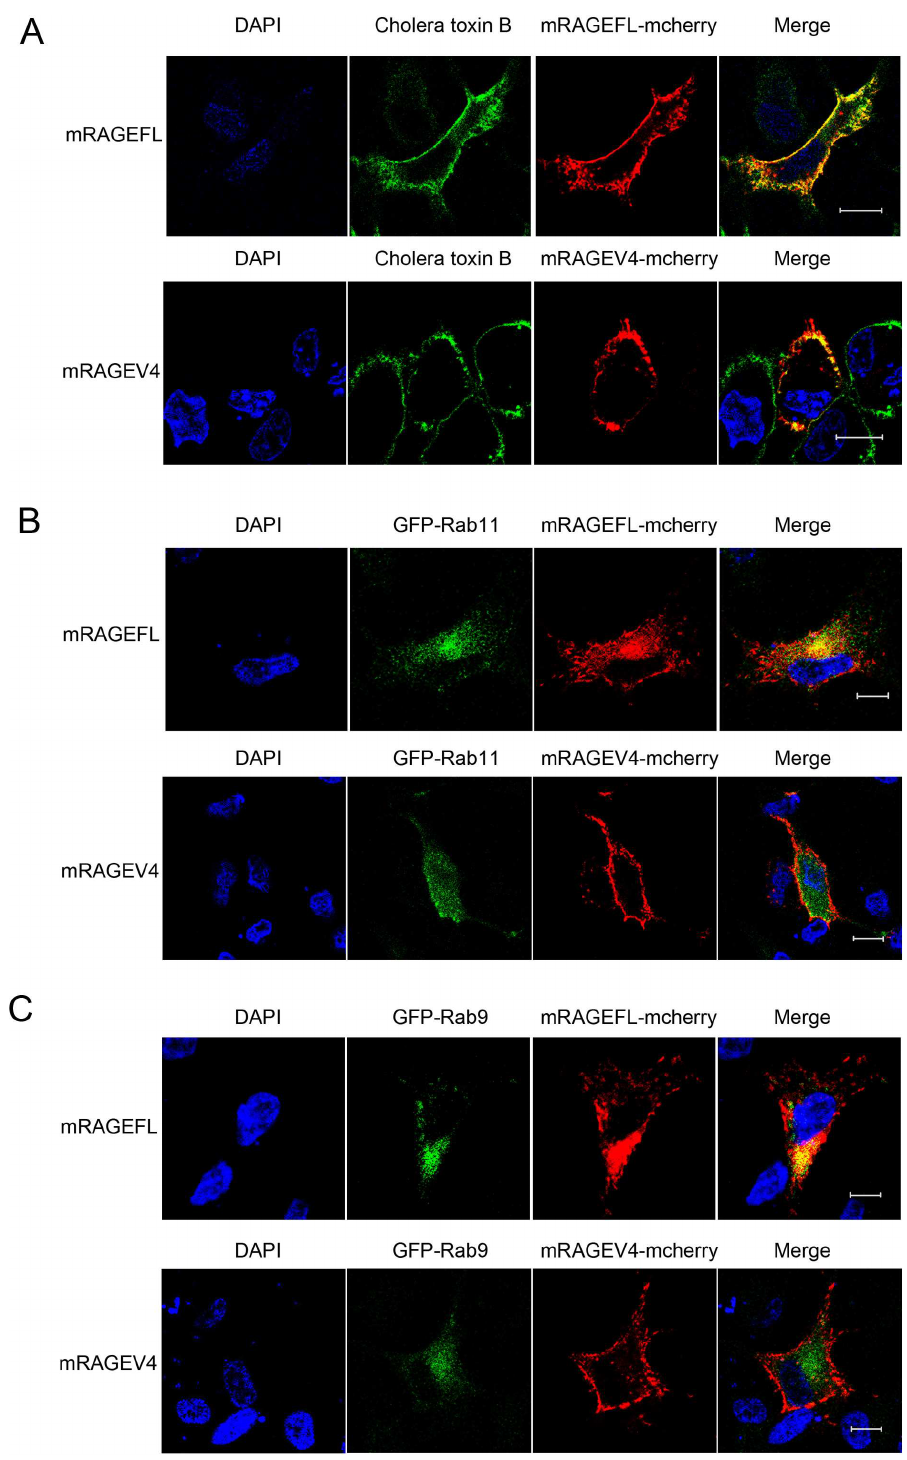
Fig 5. Examinationof cellularlocalizations of mRAGEFL and mRAGEV4. (A) Plasma membrane localization; (B) earlyendosome localization; (C) late endosomelocalization. Blue: DAPI (nucleus);red: mcherry(mRAGEFL and mRAGEV4); green:Alexa Fluor488-conjugated plasmamembranemarker cholera toxin B (A), and GFP tagged earlyendosomemarker Rab11 (B) and late endosome markerRab 9 (C).The scale bar represents10 μ